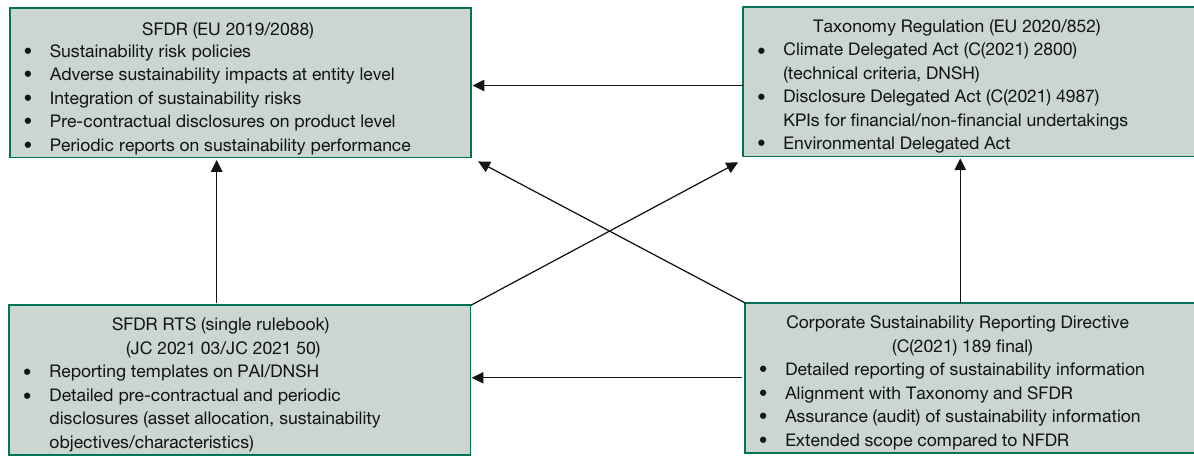
Sustainability reporting for corporates and fi nancial institutions in the